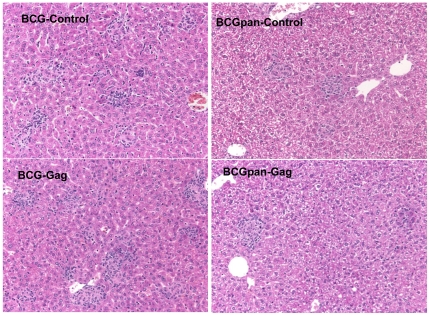
Liver sections of mice vaccinated with rBCG.Histopathology examination of formalin fixed liver sections stained with haematoxylin and eosin showing the frequency of granulomas induced by the vaccines. Magnification 200×, and a representative view from one of 3 mice per vaccine.